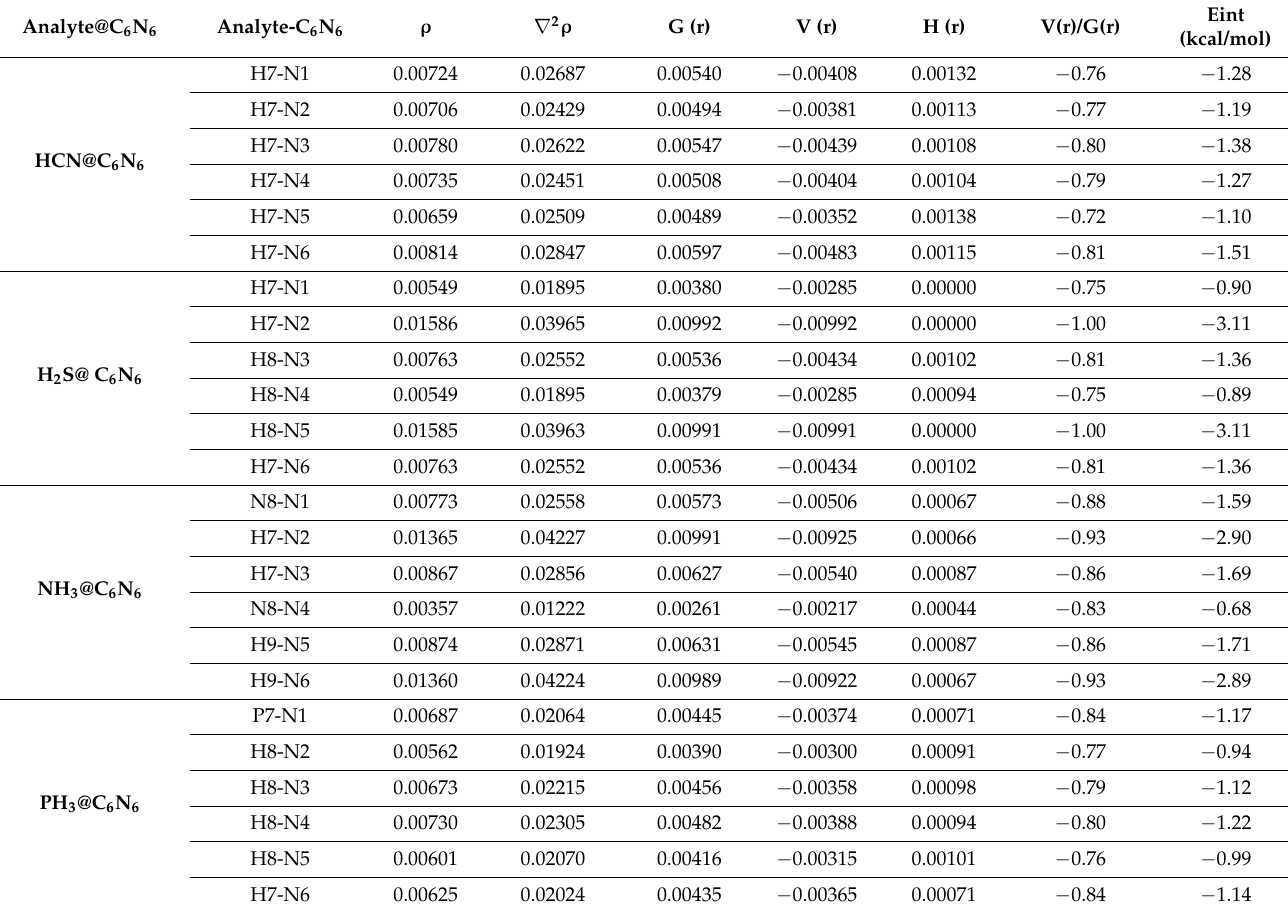
Table 2. BCP parameters values of analyte@C 6 N 6 complexes determined by QTAIM